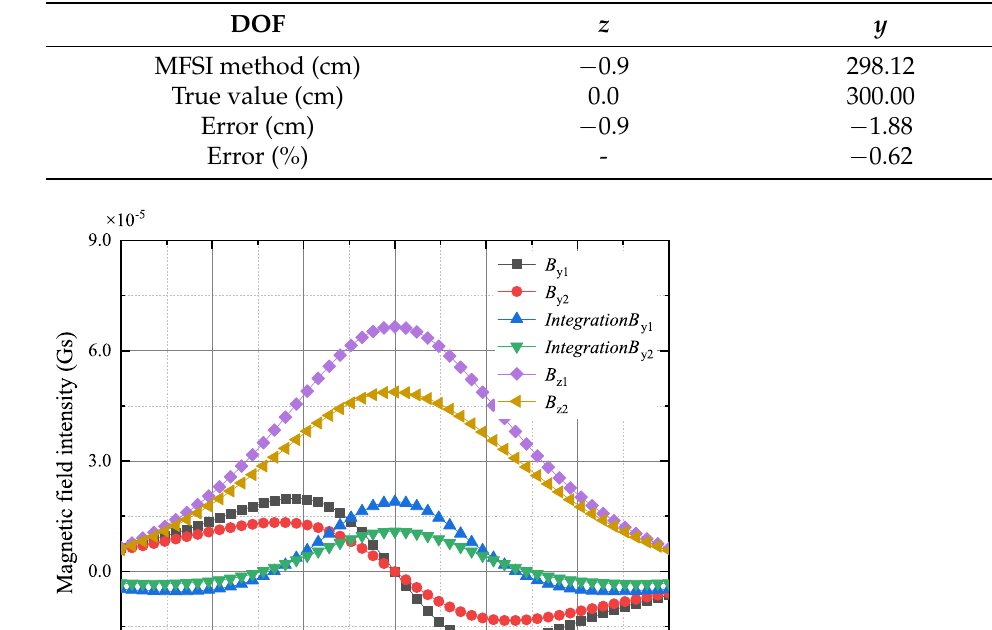
Table 1. The tracking error of the algorithm in the normal case.